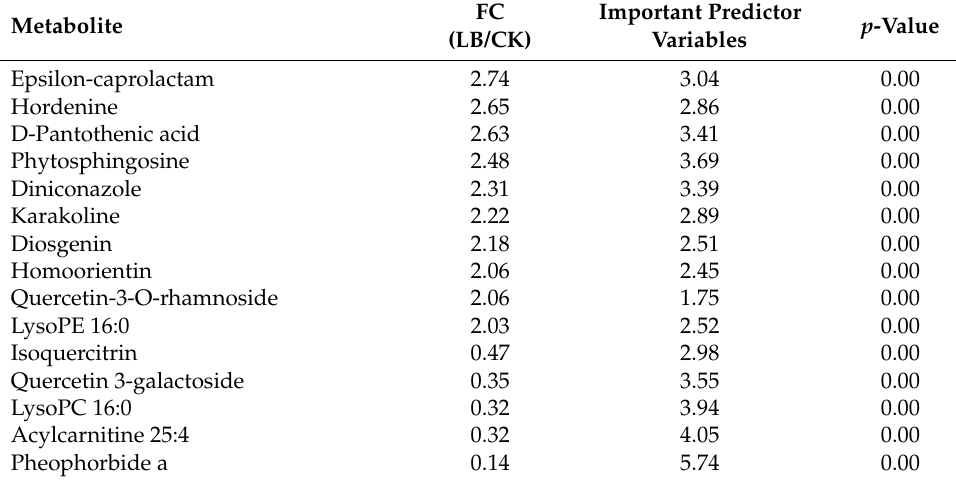
Table 7. Metabolite differences of whole crop corn silage between LB and CK